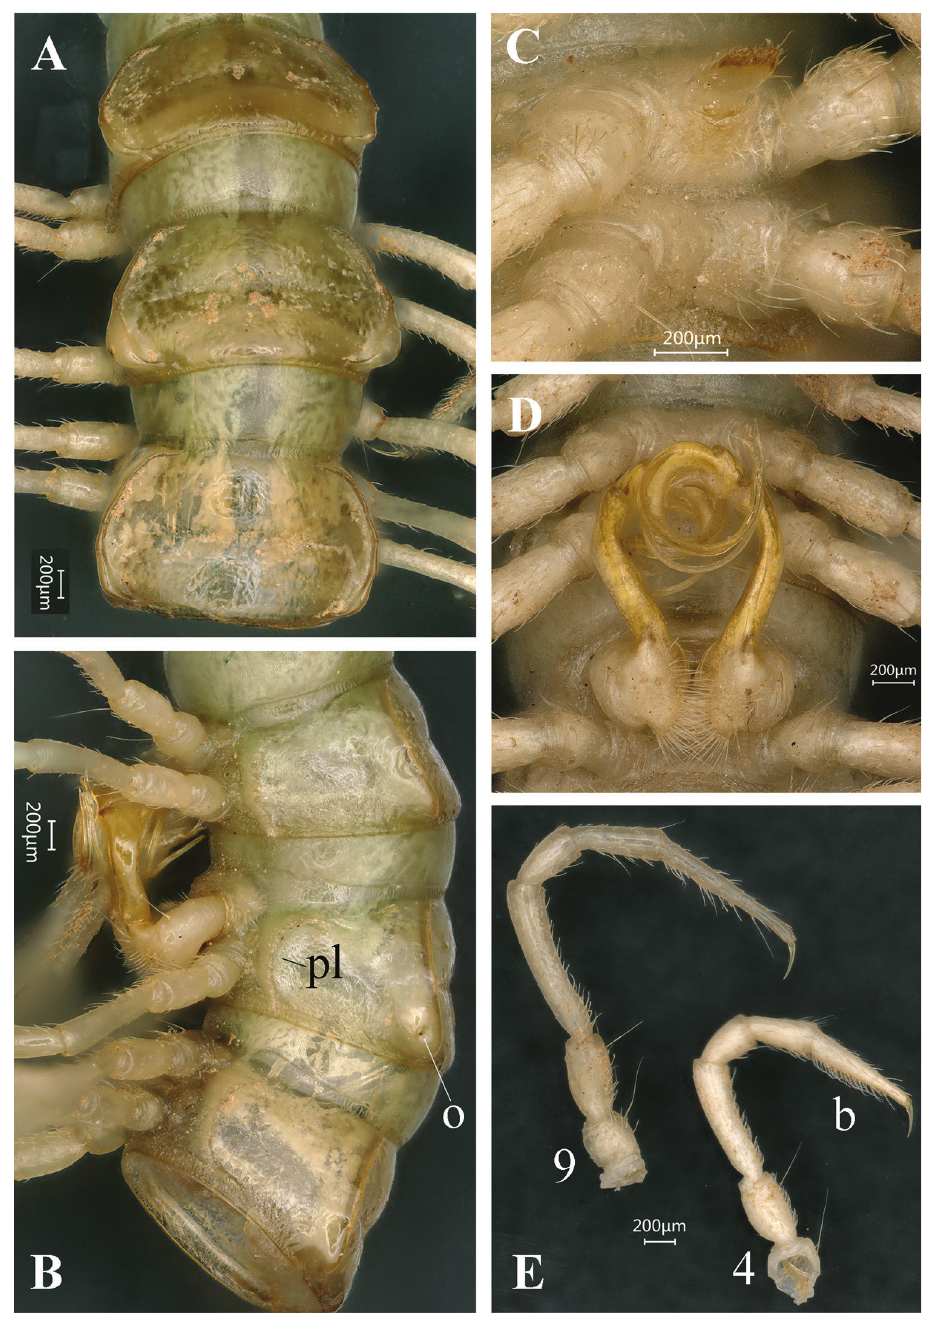
Figure 6. Tonkinosoma tiani sp. n., ♂ paratype from Ganhan Cave. A, B segments 6–8, dorsal and lateral views, respectively C sternite V, ventral view D gonopods in situ , ventral view E legs 4 and 9, anterior view. Abbreviations: b = tarsal brush; o = ozopore; pl = pleurosternal